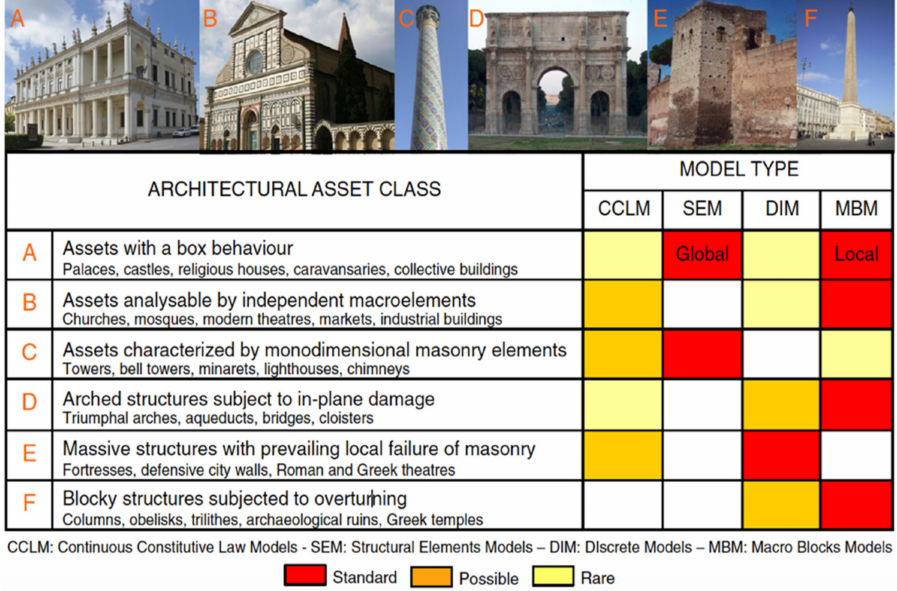
Figure 1. Classification of architectural assets and related possible modelling strategies (from